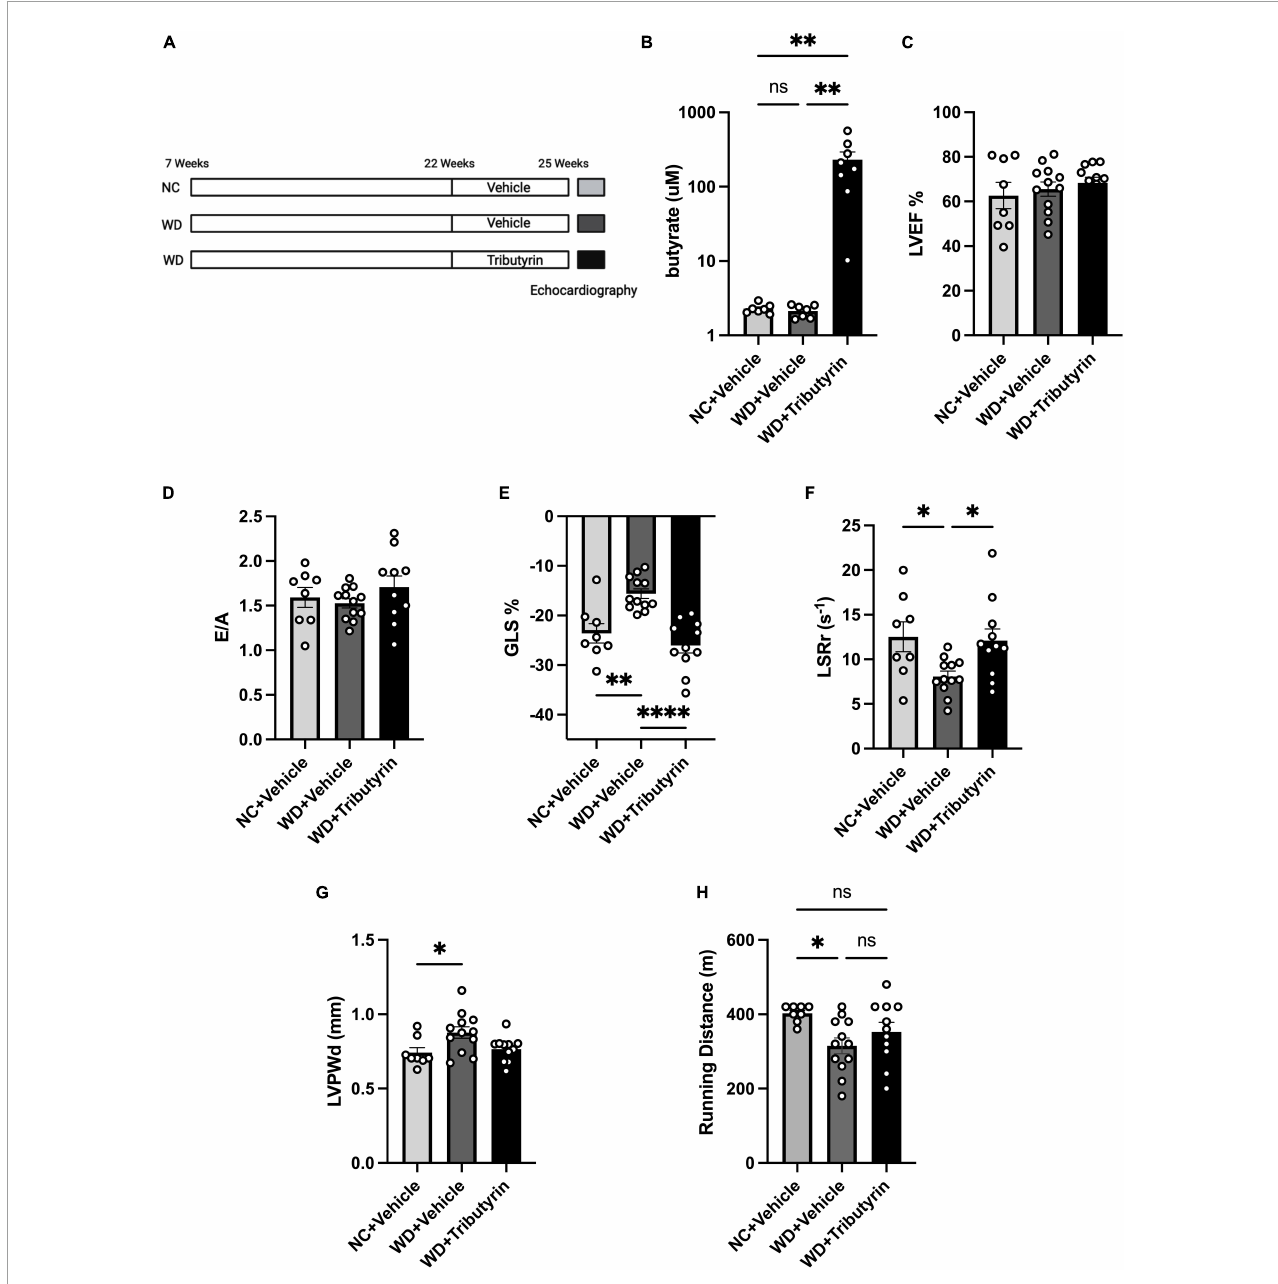
FIGURE3 Tributyrin treatment improved early cardiac dysfunction and cardiac hypertrophy in obese pre-HFpEF mice. (A) Experimental paradigm, C57BL/6J fed WD or NC for 15 weeks were treated with Tributyrin using needle feeding for 3 weeks, followed by echocardiography and exercise exhaustion test. (B) Circulating levels of butyrate in serum ( µ M), (C) echocardiography measurements of LVEF (%), (D) ratio between mitral E wave to A wave (E/A), (E) global longitudinal strain (GLS) (%), (F) longitudinal strain rate reverse (LSRr) (S - 1 ), (G) left ventricle posterior wall diameter (mm). (H) Running distance during exercise exhaustion test (m). Statistical analysis was done using one-way ANOVA followed by Tukey’s multiple comparison test. Data are mean ± S.E.M. ( ∗ p < 0.05, ∗∗ p < 0.005, and ∗∗∗∗ p < 0.00005), ( n = 8–12 per